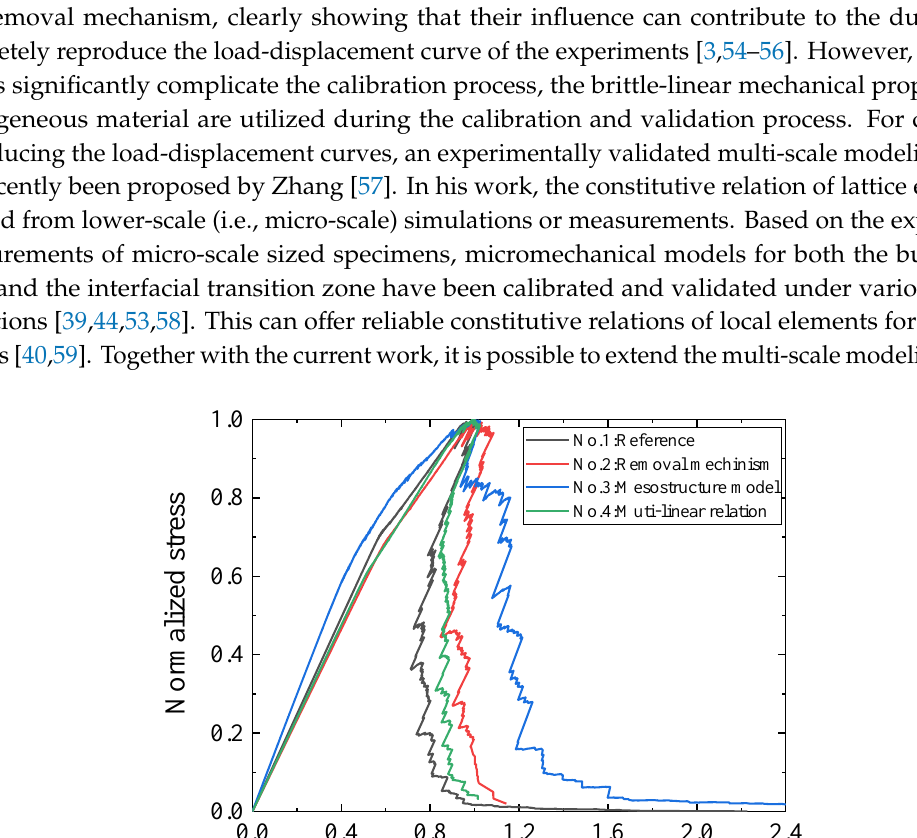
Table 9. The input parameters for the numerical analysis.